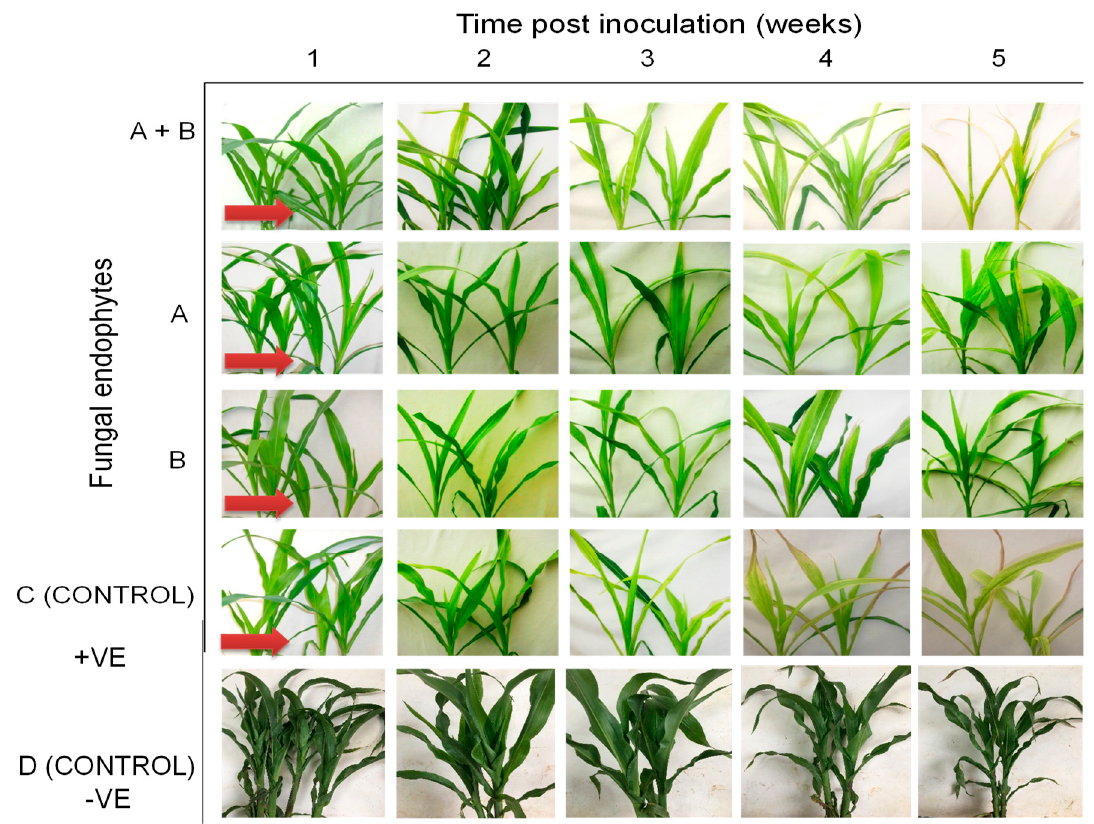
Figure 11. Disease symptom development in maize plants treated with fungal isolates ( A ) ( Trichoderma harzianum -F2L4), ( B ) ( Metarhizium anisopliae -ICIPE 69), and A + B (combination of the two isolates-F2L4 and ICPE 69) following dual inoculation with Maize chlorotic mottle virus and Sugarcane mosaic virus . ( C ) represents the positive control, where untreated maize plants were challenge co-inoculated with MCMV and SCMV, while ( D ) represents the negative control, where plants were neither treated with fungal endophytes nor challenge-inoculated with viruses. The arrows indicate the onset of symptom expression in various treatments. Challenge-inoculation with MCMV was conducted 21 days after planting.